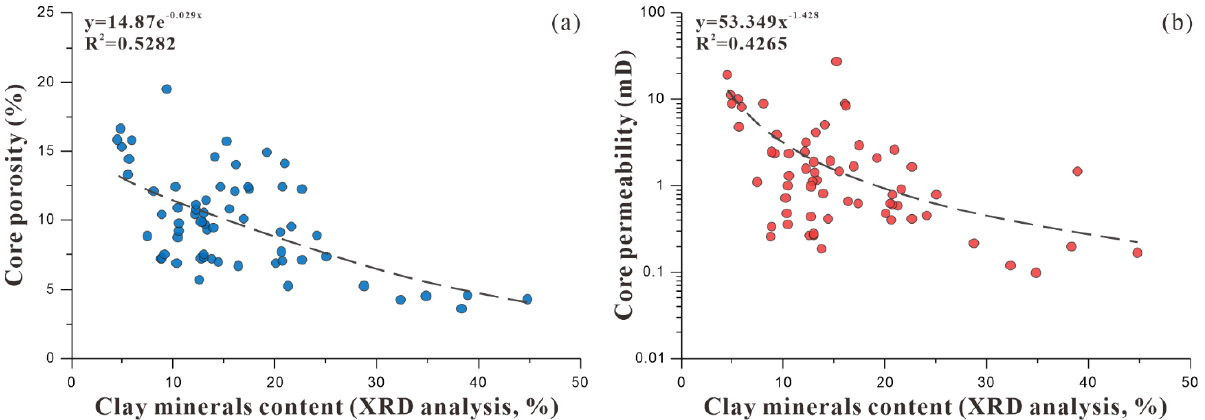
Figure 16. Total content of clay minerals with ( a ) core porosity and ( b ) core permeability of the Lower Jurassic reservoir in the Niudong area, northern margin of Qaidam Basin.